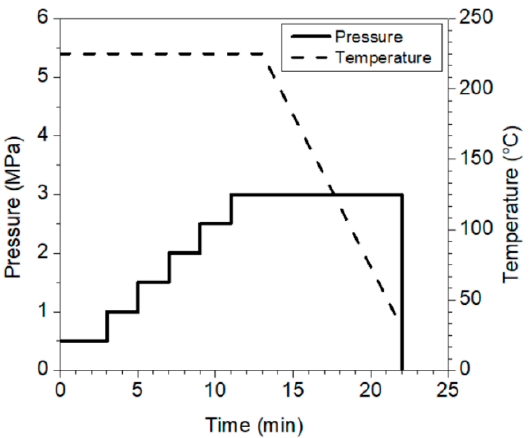
Figure 1. Processing conditions for the preparation of all basalt-reinforced laminates.